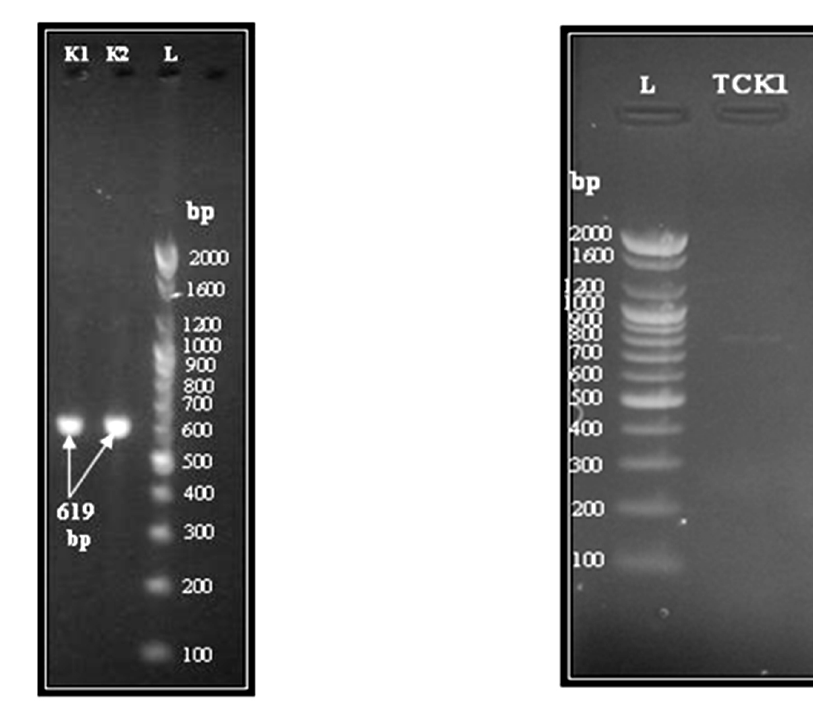
table 3. Characteristics of carbapenem-resistant K.pneumoniae clinical isolates and their conjugates Isolate OXA-1